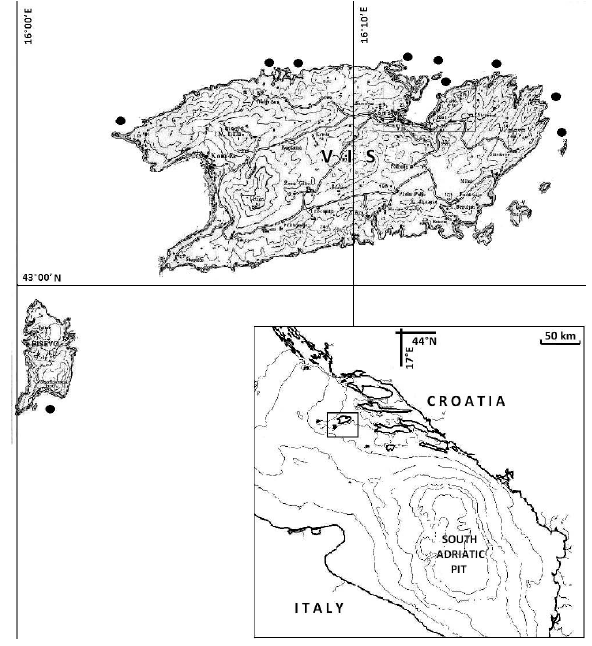
Fig . 1. – The study area in the central Adriatic Sea with sampling locations around Vis